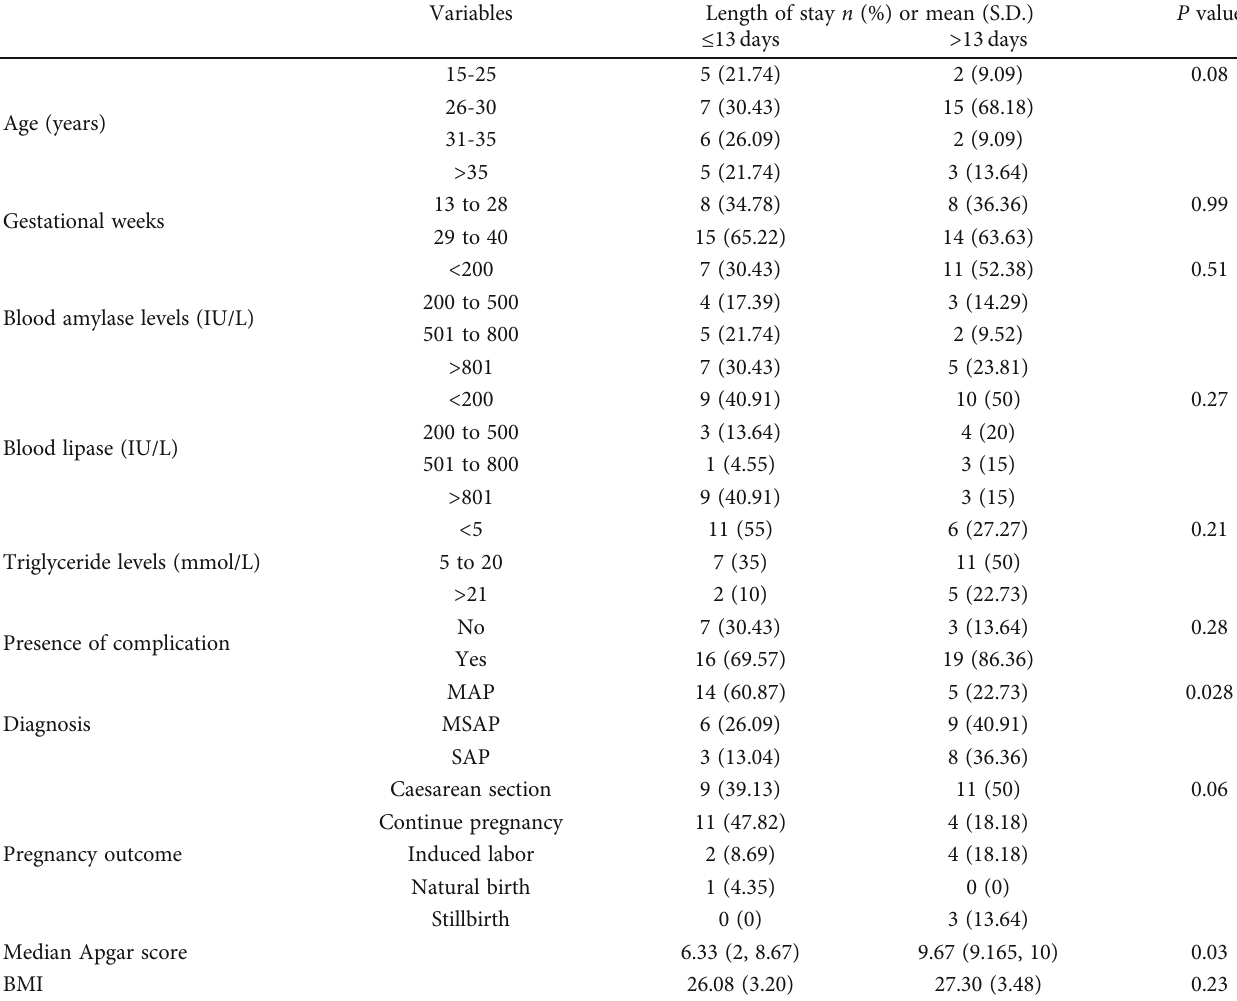
Table 5: Association between length of stay at hospital and other clinical parameters.